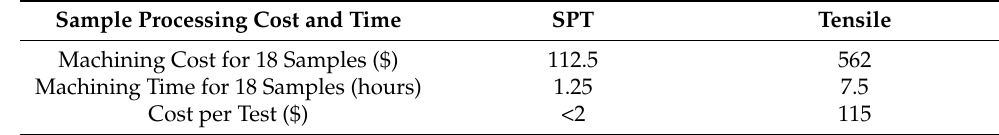
Table 2. Cost comparison between SPT and